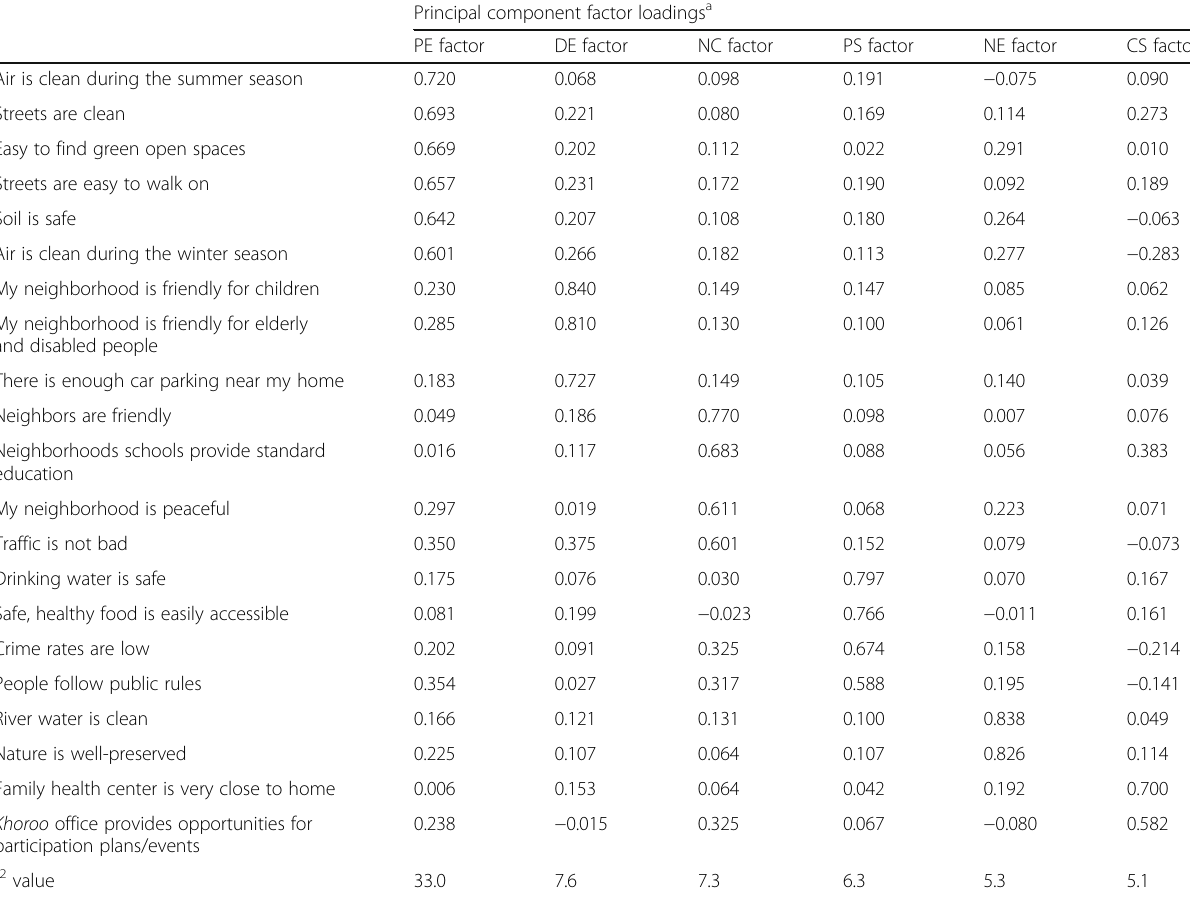
Table 2 Principal component analysis of perceptions of neighborhood environment in Ulaanbaatar ( n =